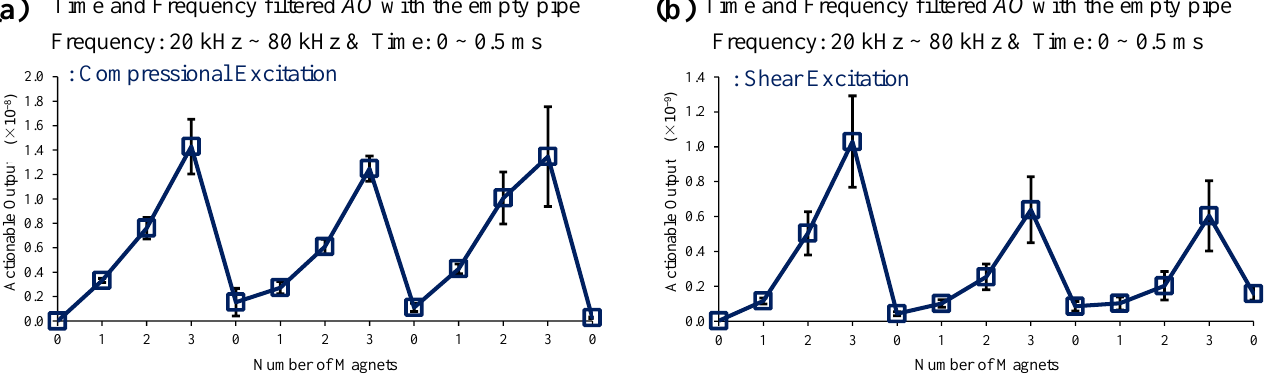
Figure 8. Changes in AO with the different number of magnet perturbations: the empty pipe with ( a ) compressional and ( b ) shear excitations. Simple time and frequency filtering lead to improved detection.